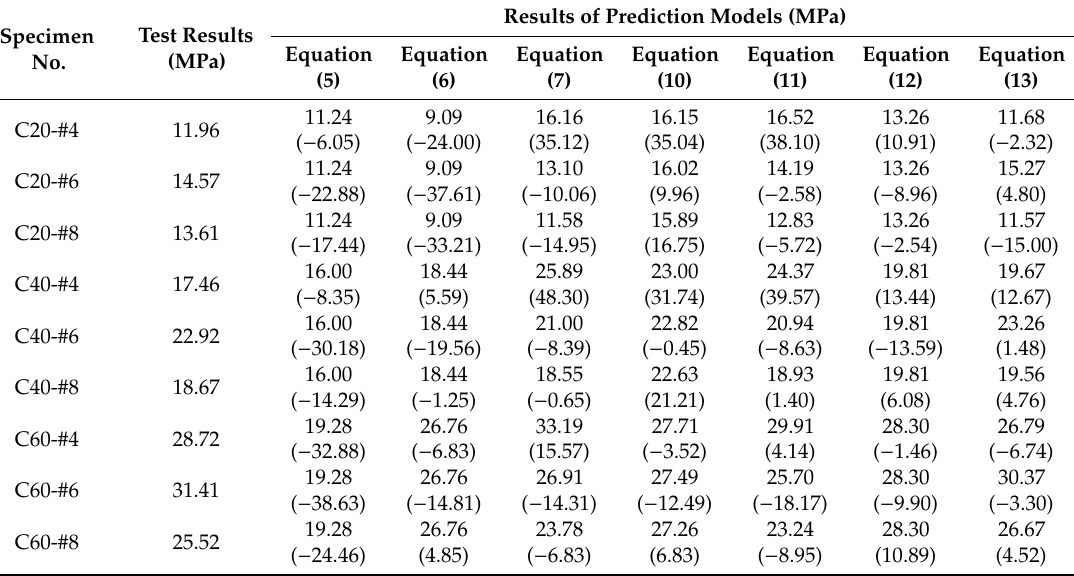
Table 7. Comparison of ultimate bond stress between the test result and prediction models.